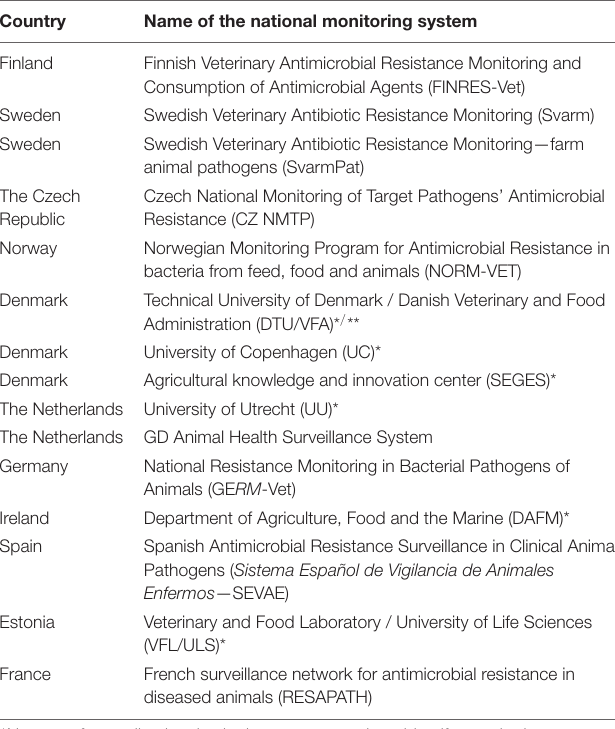
TABLE 1 | List of 15 national monitoring systems for antimicrobial resistance in bacterial pathogens of animals described and analyzed in the study.